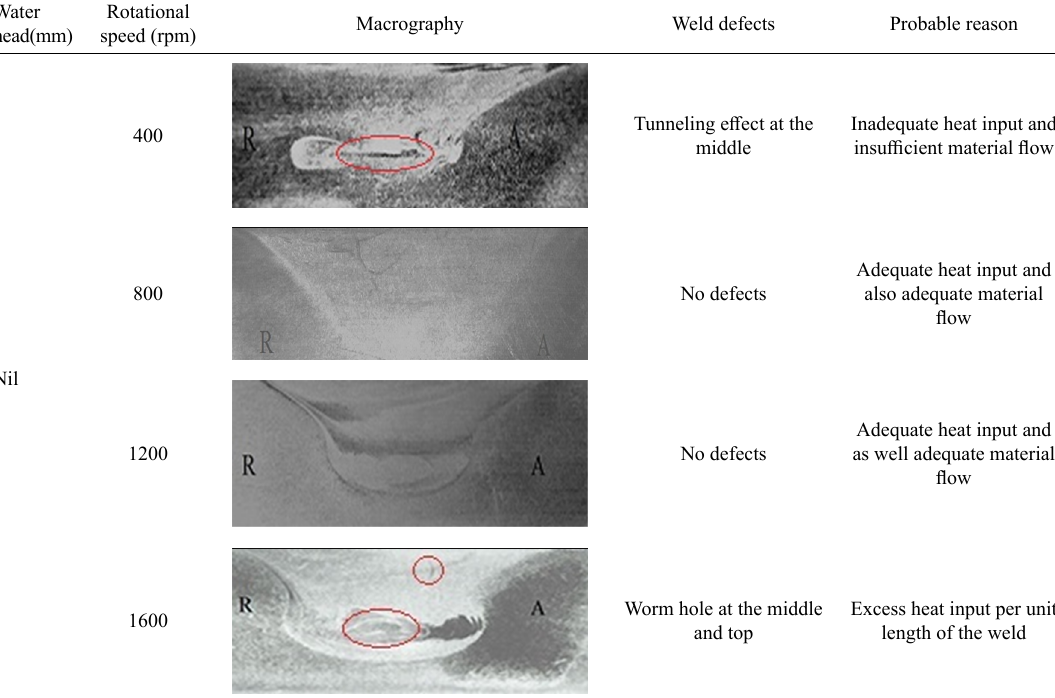
Figure 8 . Weld power on the welds (a) without water head (b) with 10 mm water head (c) with 20 mm water head (d) with 30 mm water head Table 2. Macrostructure observation of 6061-T6 aluminium